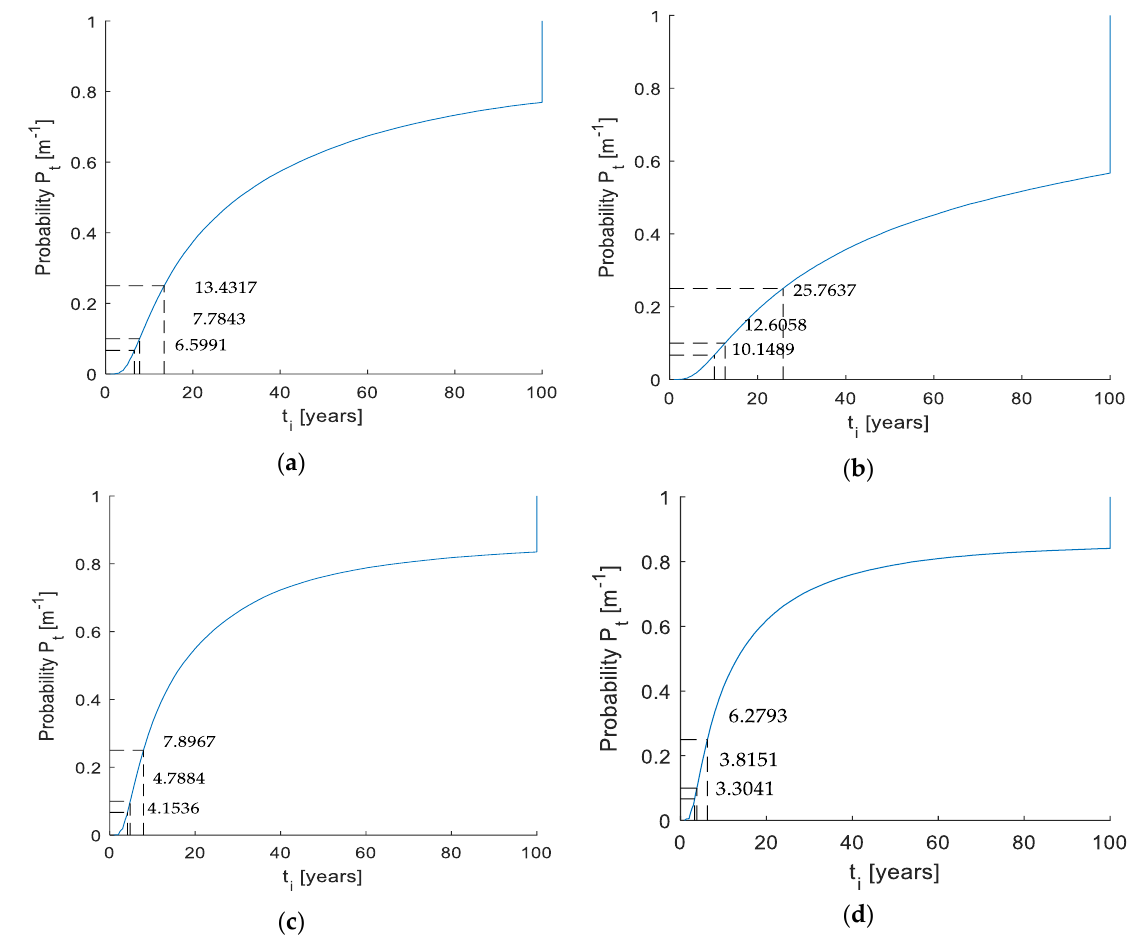
Figure 1. Probability of corrosion initiation is viewed as a quantity function: ( a ) OPC, ( b ) SCC 0%, ( c ) SCC 1%, ( d ) SCC 2%.